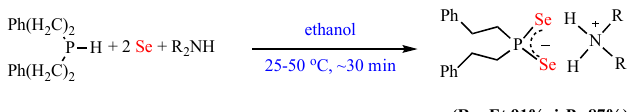
Scheme 14. Synthesis of diselenophosphinates.